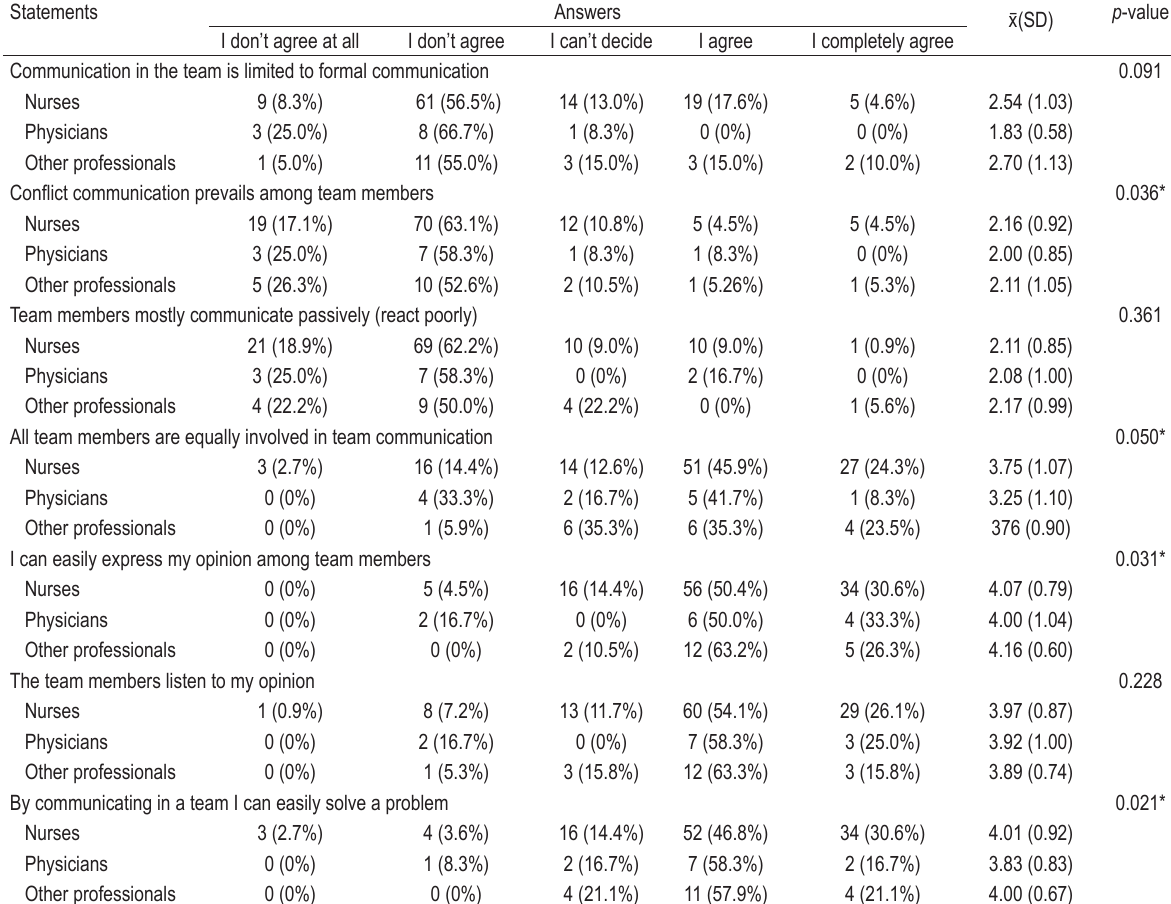
TABLE 2. Assessment of interprofessional team communication by professions (Kruskal‑Wallis